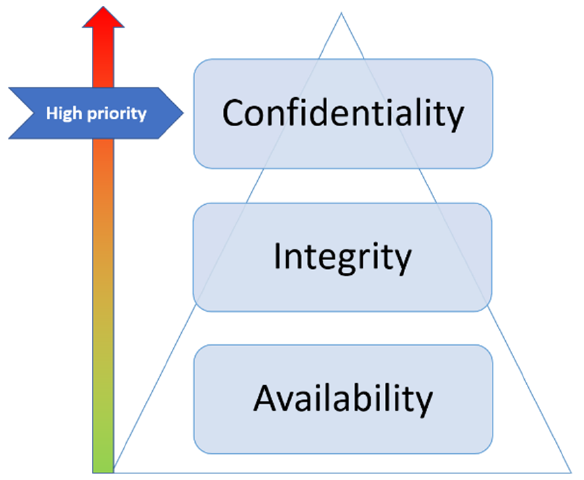
Figure 7. Priority of security requirements for AMI.